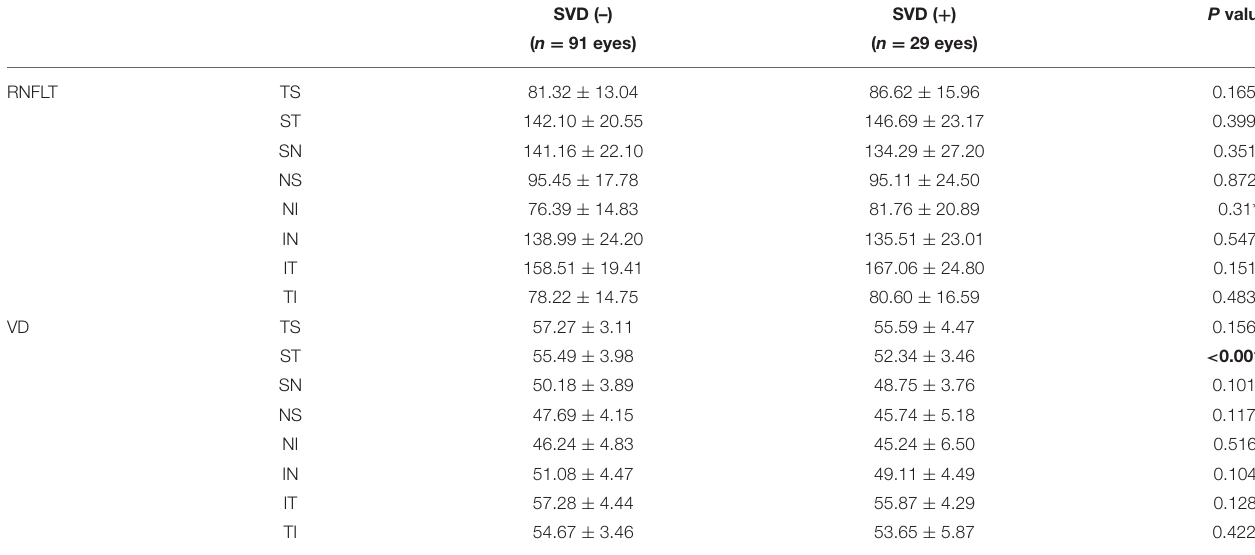
TABLE 2 | Comparison of peripapillary retinal nerve fiber layer thickness and RPC vessel density between subjects with and without SVD.